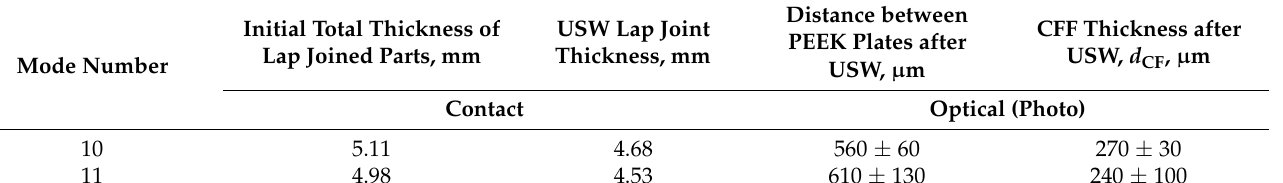
Table 6. The mechanical and dimensional characteristics of the USW lap joints obtained with the parameters optimized by ANN simulation. Table 7. The dimensional characteristics of the USW lap joints obtained with the parameters opti- mized by ANN simulation.